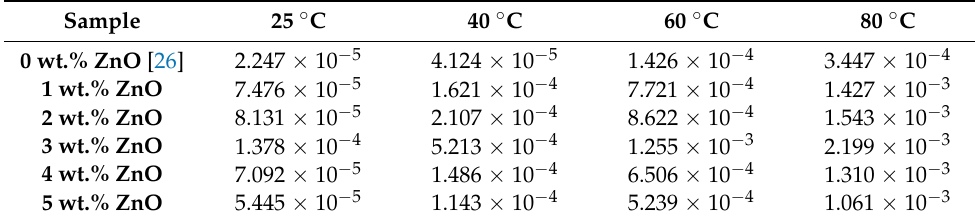
Table 4. Ionic conductivity ( σ (S · cm − 1 )) of the SPEs at different temperatures.